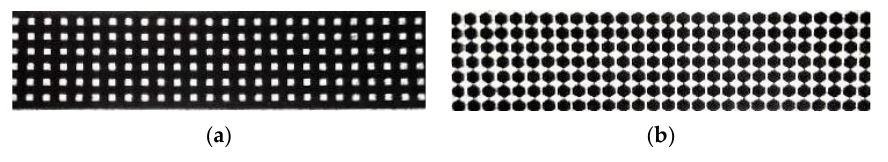
Figure 5. line pattern ( a ); dot pattern ( b ). Figure 5. Line pattern ( a ); dot pattern ( b